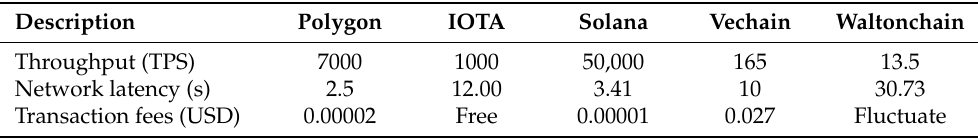
Table 1. Performance Comparison Among Public